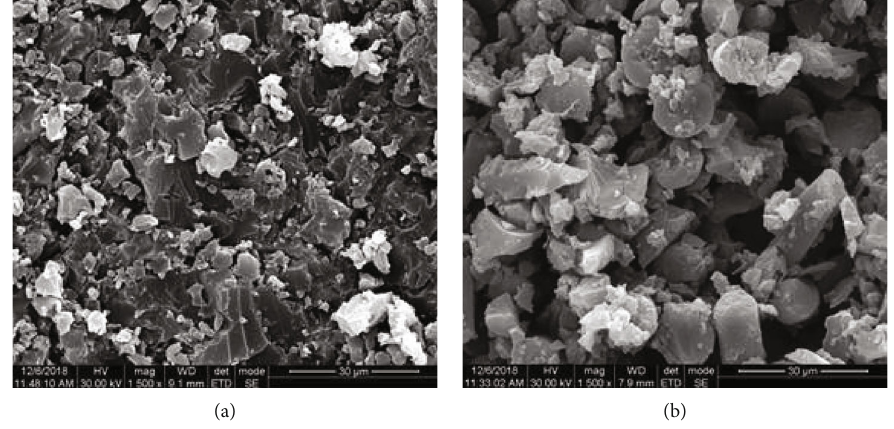
Figure 2: FESEM micrographs. (a) 1.5wt.%. (b)